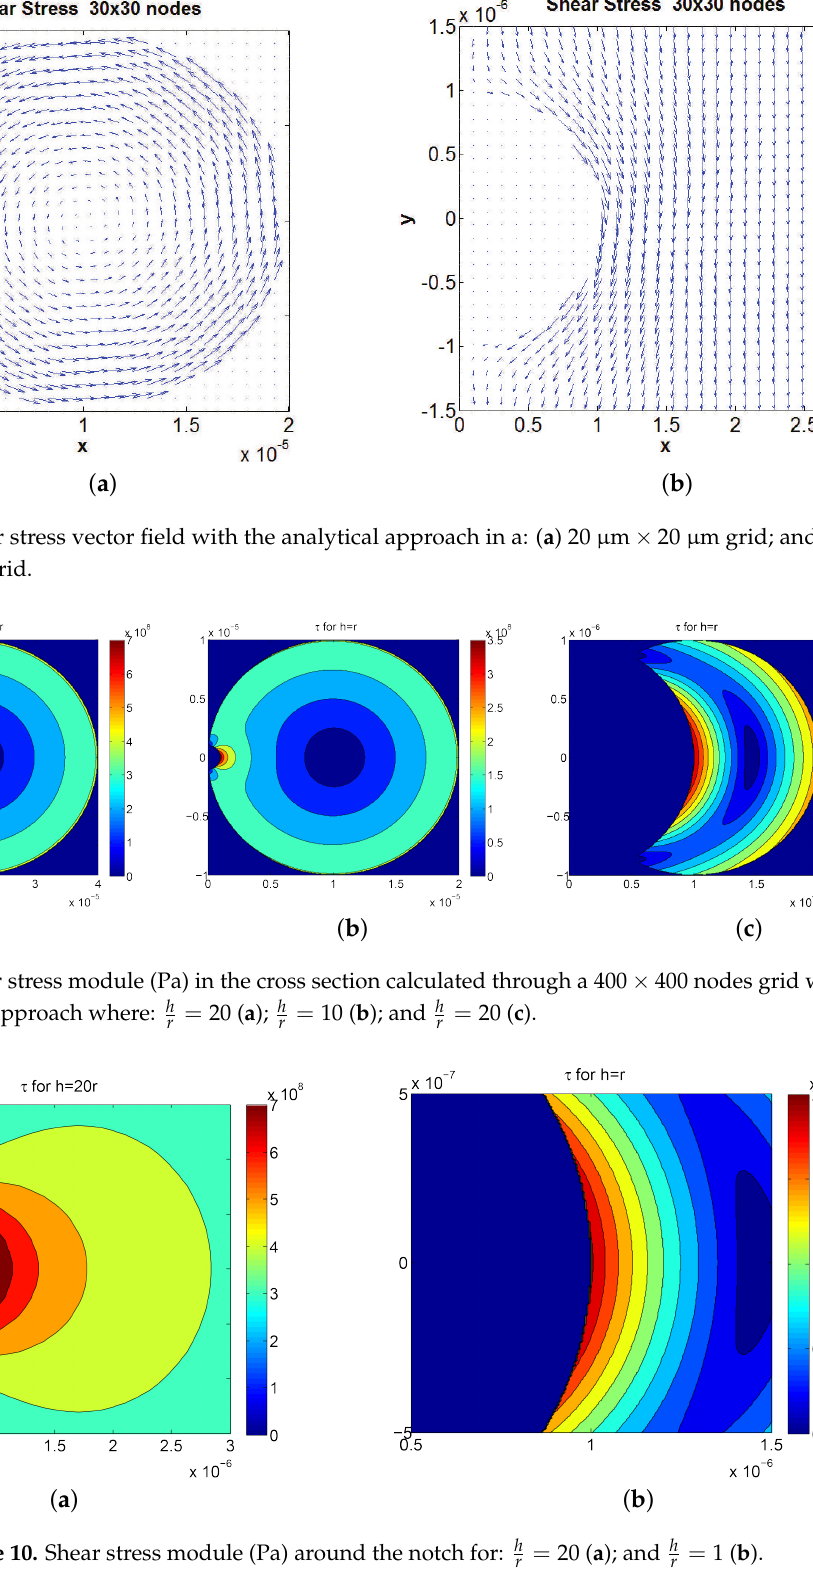
Figure 10. Shear stress module (Pa) around the notch for: h Stress is concentrated around the circular arc midpoint, being the point where the maximum stress is